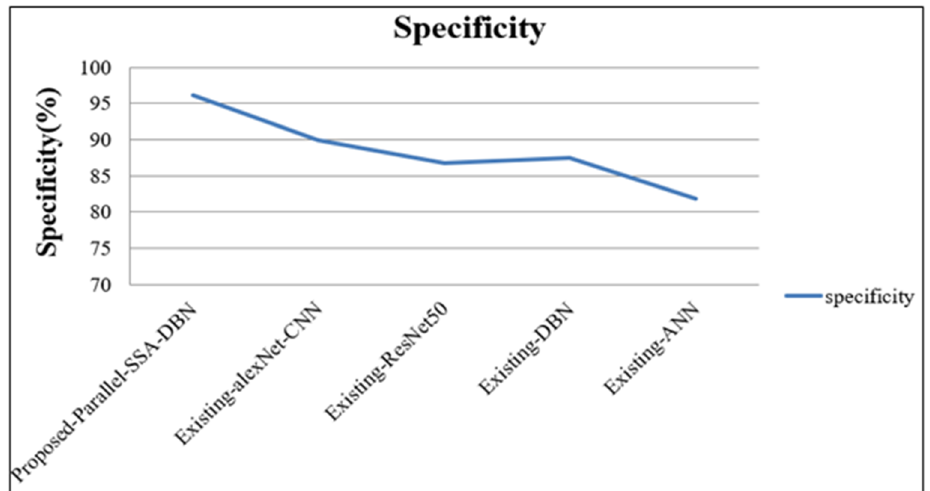
Figure 6. Graphical demonstration of classification metrics for proposed method along with existing methods. Table 2. Evaluation of classification metrics for proposed parallel SSA-DBN on FPR, MCC, FRR, computation time and